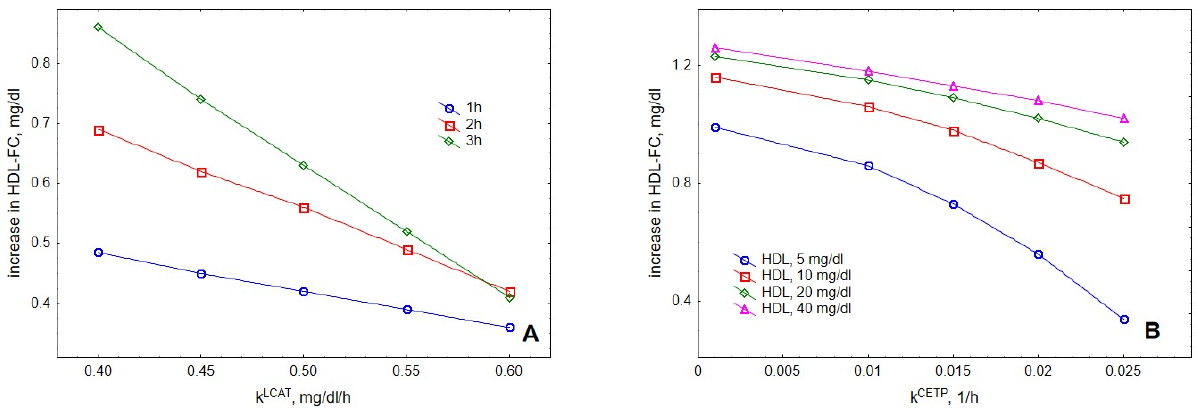
Figure 8. Influence of LCAT (A) and CETP (B) activities on the accumulation of cholesterol in HDL. Mathematical modelling was performed under conditions of in vitro TGRL lipolysis described elsewhere [25] for the reaction time of 1 (blue circles), 2 (red squares) and 3 (green diamonds) h ( A ). In order to calculate accumulation of cholesterol in HDL, its content at baseline (t = 0) was subtracted from the results of the modelling. Initial concentrations: VLDL-TG, 30 mg/dl; LPL, 190 U/mL. ( A ) HDL, 40 mg total mass/dl; ( B ) HDL, 5 (blue circles), 10 (red squares), 20 (green diamonds) and 40 (purple triangles) total mass/dl; reaction time, 2 h.